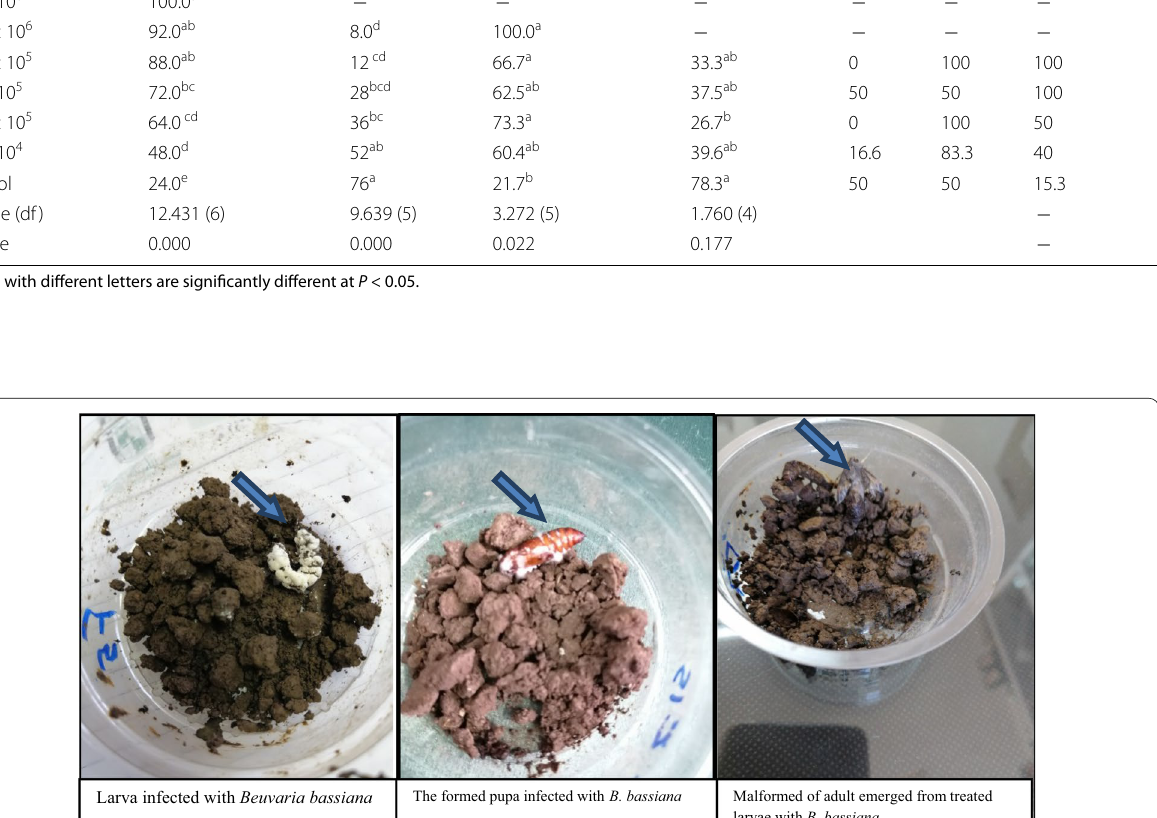
Fig. 2 Effect of entomopathoginic fungus isolated from the soil on different stages of Agrotis